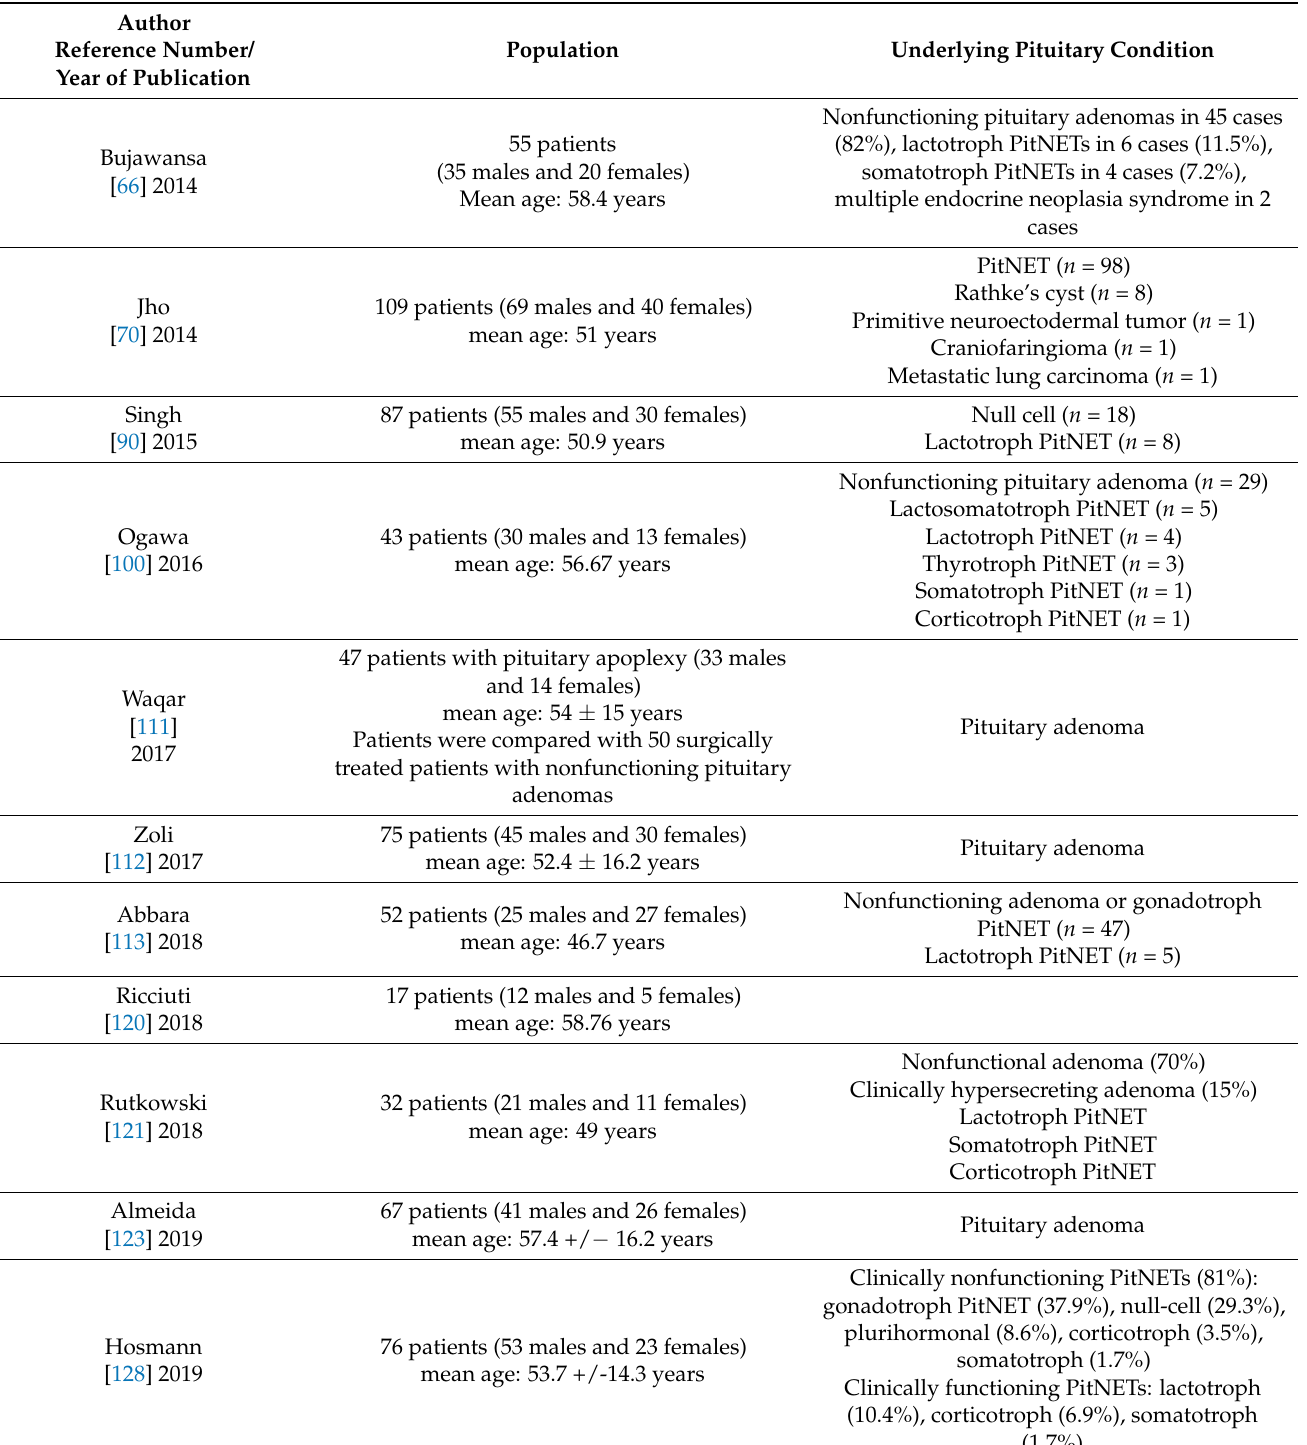
Table 3. Retrospective studies with minimum 10 patients confirmed with PA/study according to